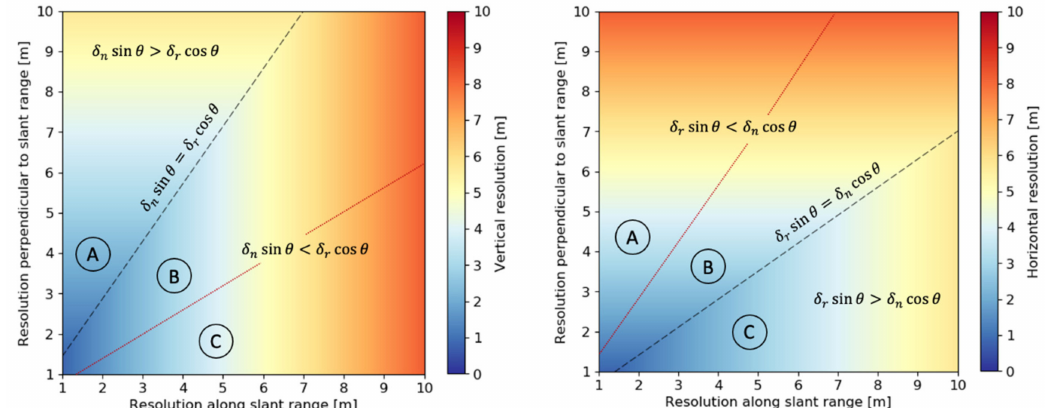
Figure 4. Vertical ( δ z ) and horizontal ( δ x ) TomoSAR resolutions as a function of the resolution perpendicular to slant range ( δ n ) and resolution along slant range ( δ r ) for look angle θ = 35 ◦ . The dotted red line in one plot represents the dashed (threshold) line in the other